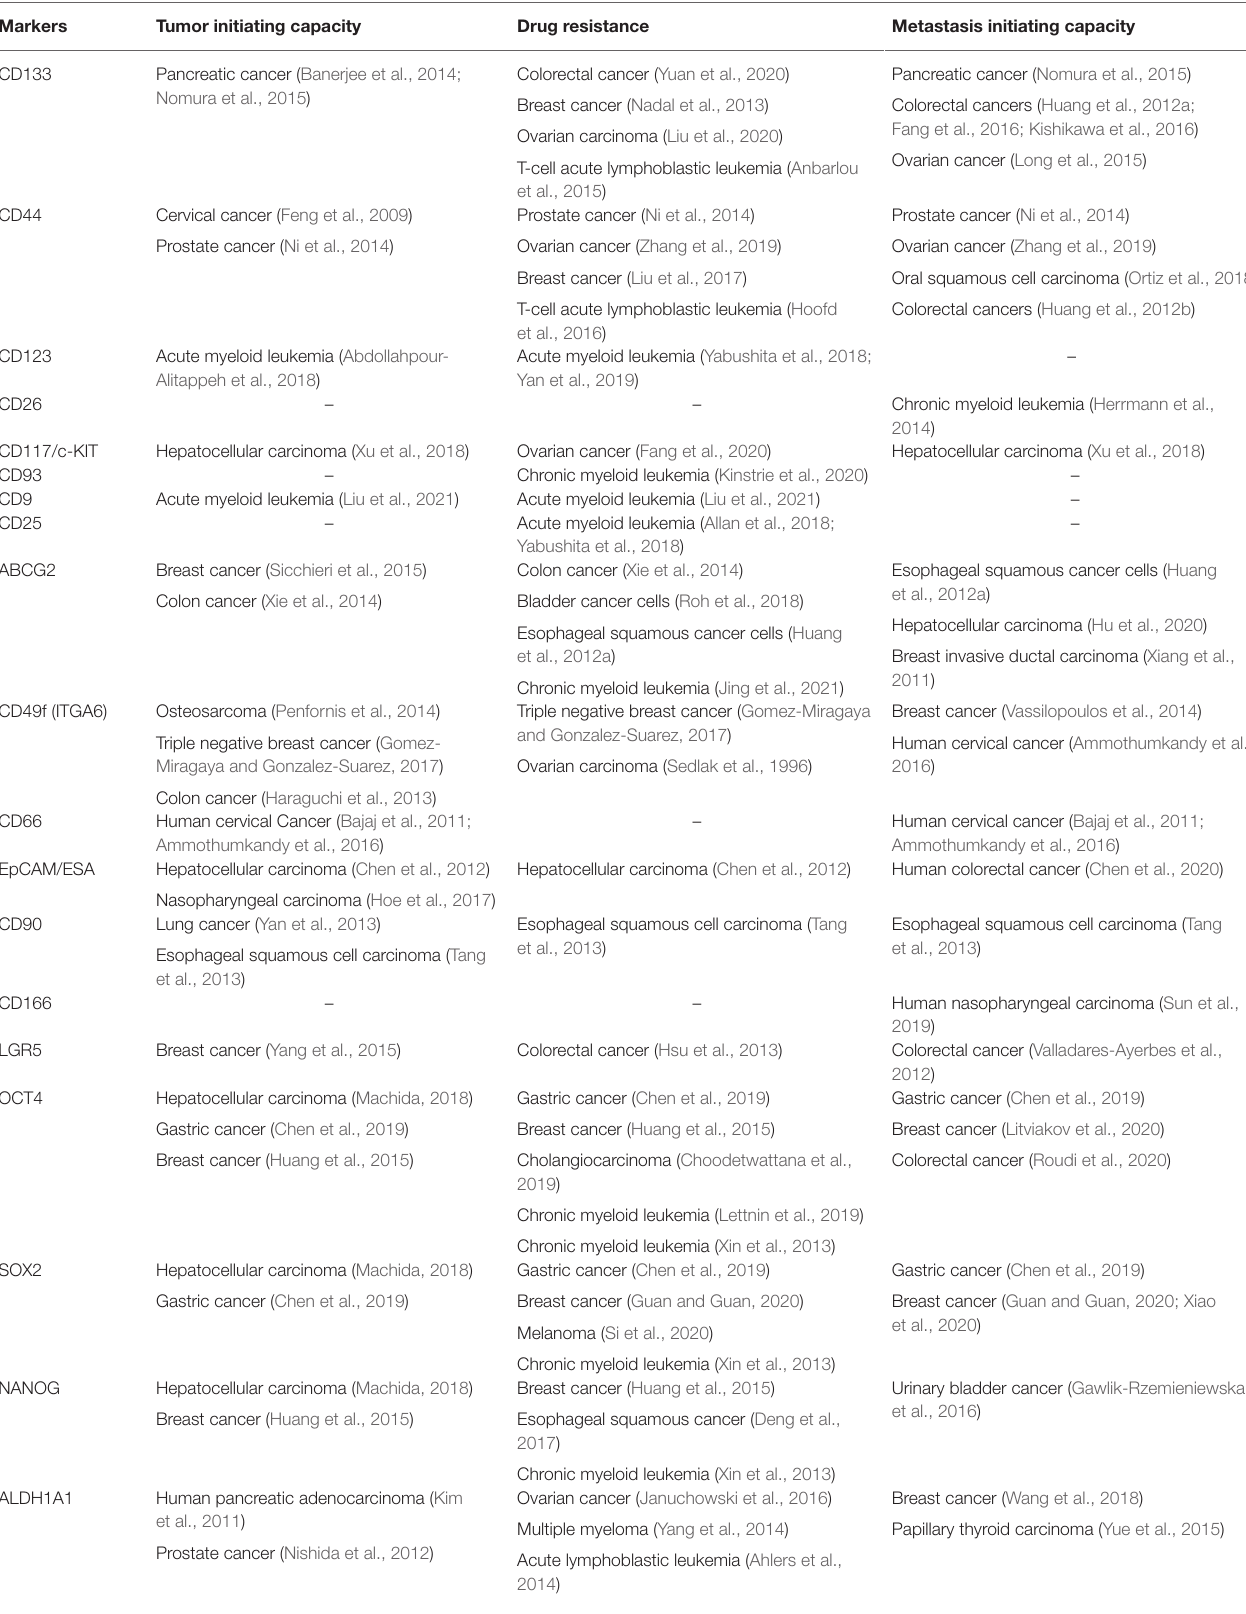
TABLE 1 | CSC markers identified in different